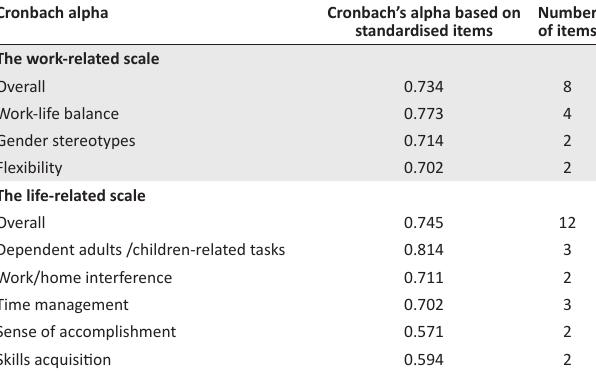
TABLE 3: Reliability statistics for the work-related scale and the life-related